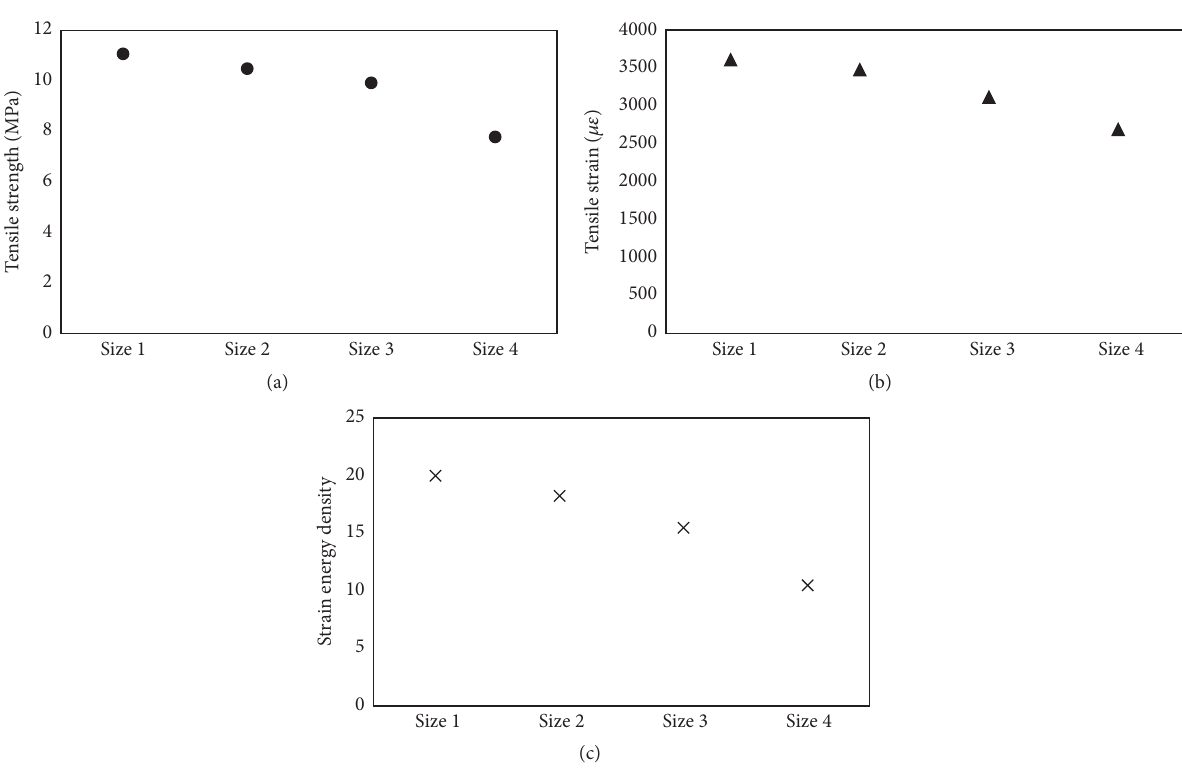
Figure 14: Effects by air void size on low-temperature property: (a) tensile stress; (b) tensile strain; (c) strain energy